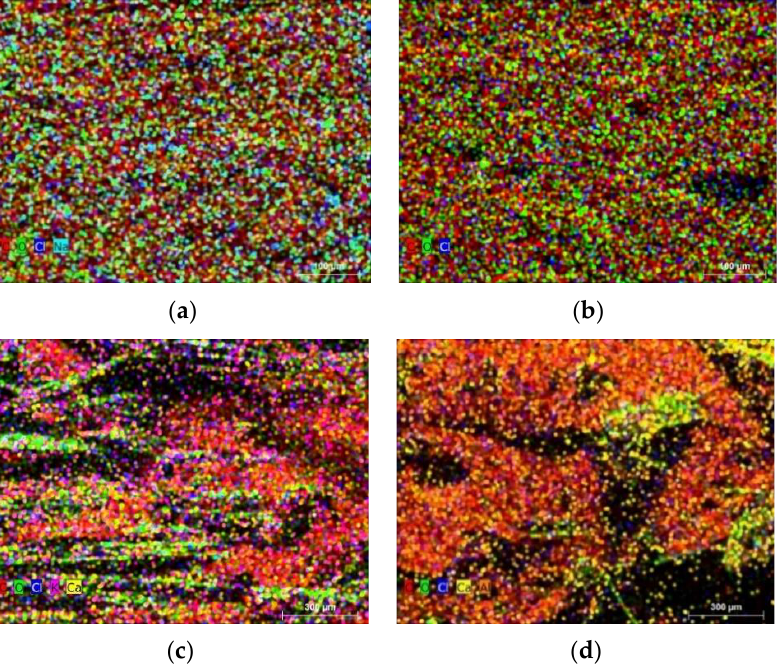
Figure 11. SEM images for map data of hybrid composites ( a ) B/E at surface, ( b ) B/E/G10 at surface, ( c ) B/E at fracture and ( d ) B/E/G10 at fracture.